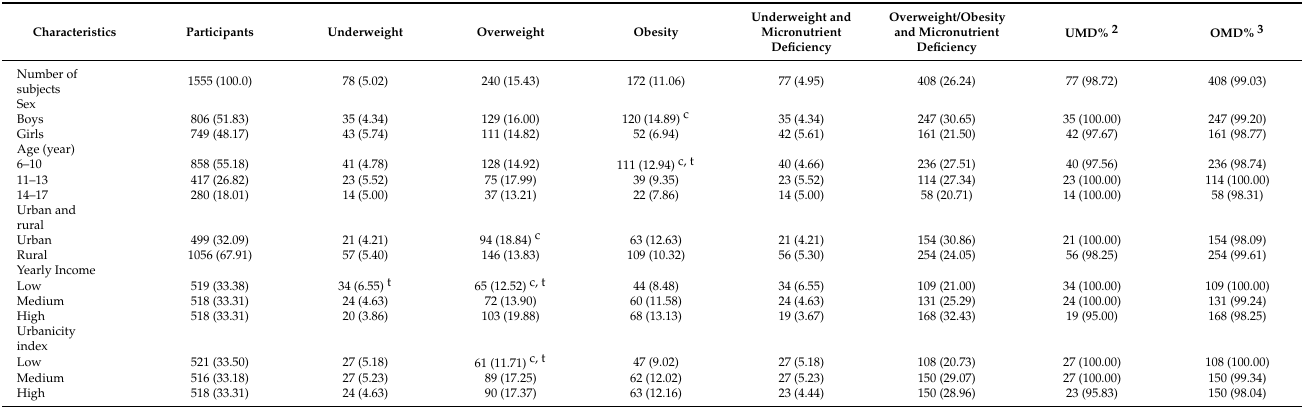
Table 1. Characteristics of study participants and prevalence of multiple forms of malnutrition, the China Health and Nutrition Survey (CHNS) 2015 1 .